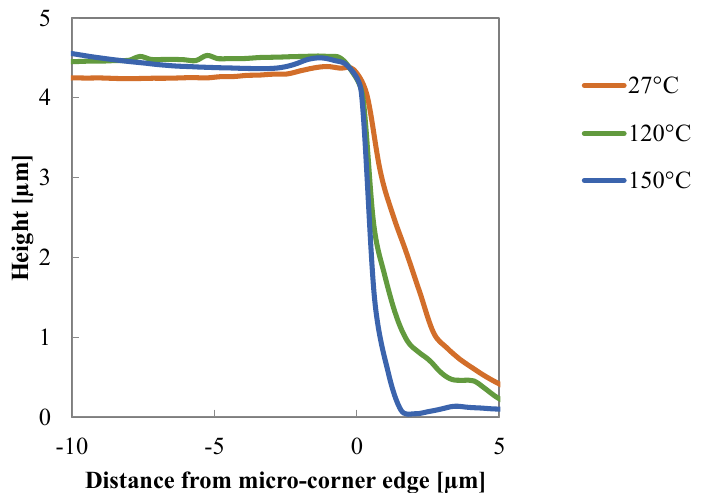
Figure 7. AFM height profiles acquired on the crosses obtained in the molded samples.